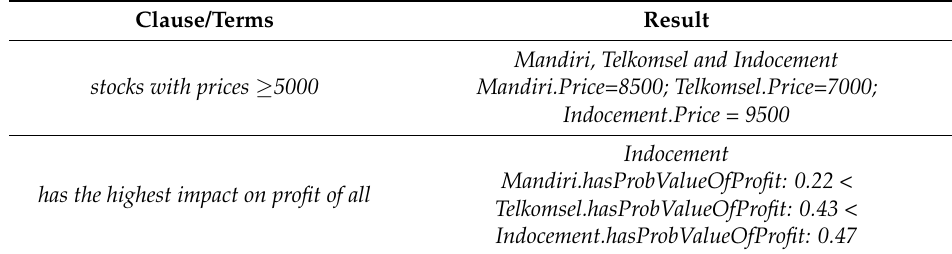
Table 6. Investment #2—Determining the query answer using the ByNowLife reasoning